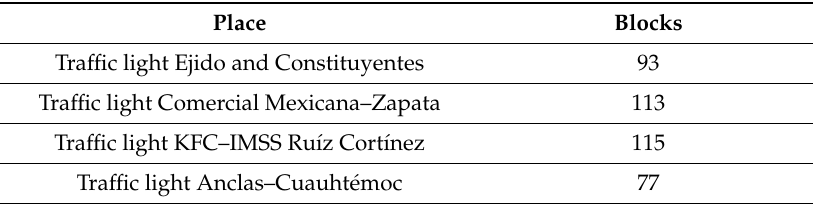
Table 1. Number of blocks within a radius of 500 m at every tra ffi c light.